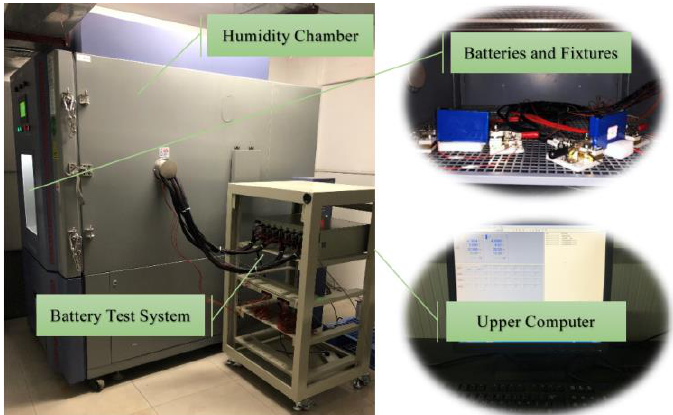
Figure 3. Experimental platform.